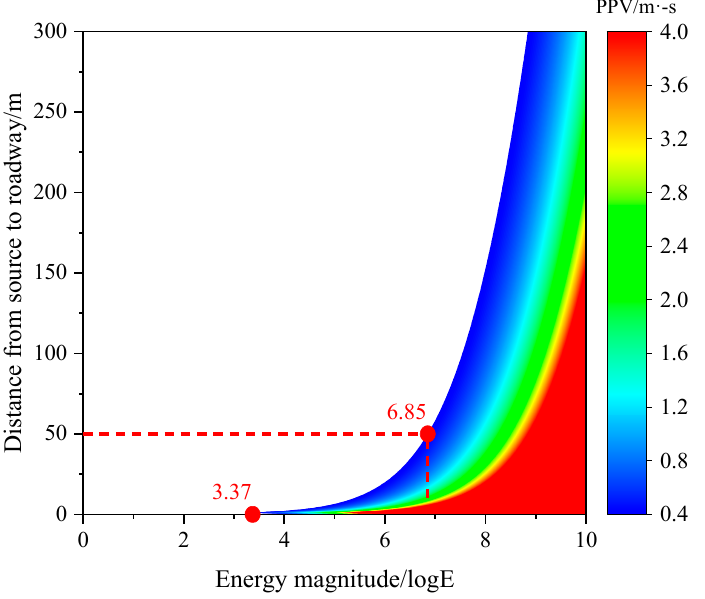
Figure 15. PPV contour cloud diagram of roadway disaster-causing model.